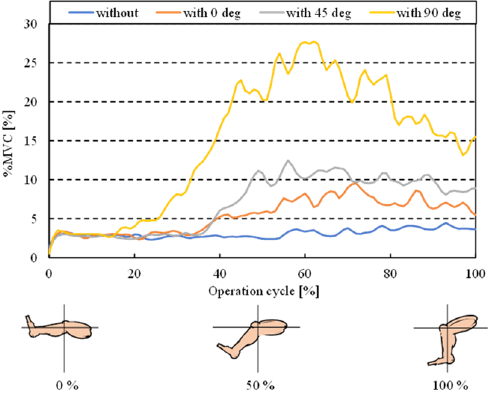
Figure 24. The result of the training